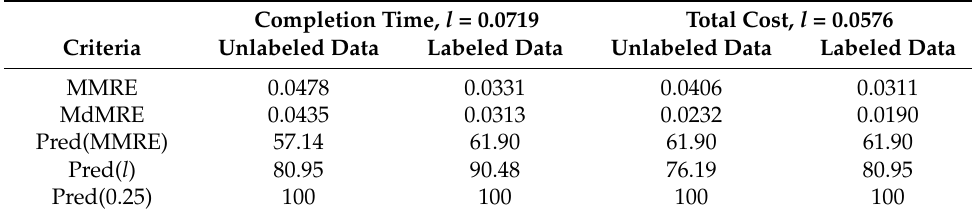
Table 9. Comparison of RF evaluation